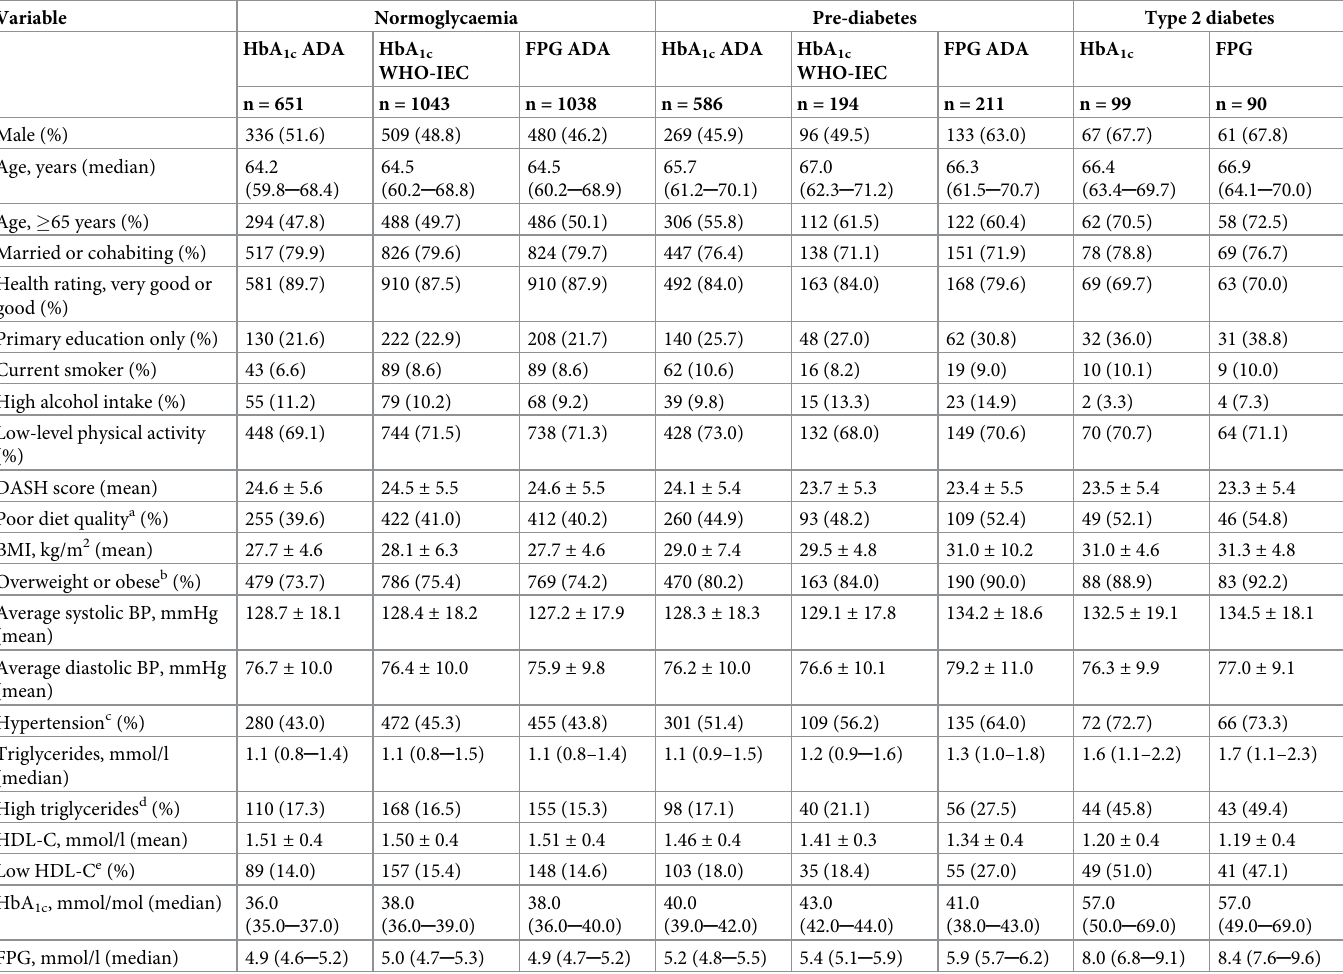
Table 1. Characteristics of the study population according to glycaemic status by glycated haemoglobin A 1c (HbA 1c ) or Fasting Plasma Glucose